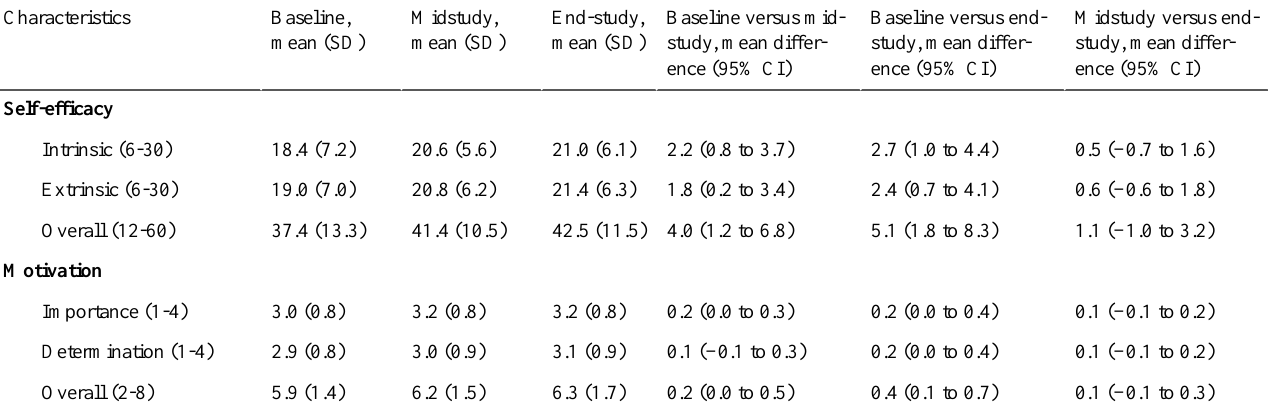
Table 2. Mean self-efficacy and motivation to quit scores across different study time points